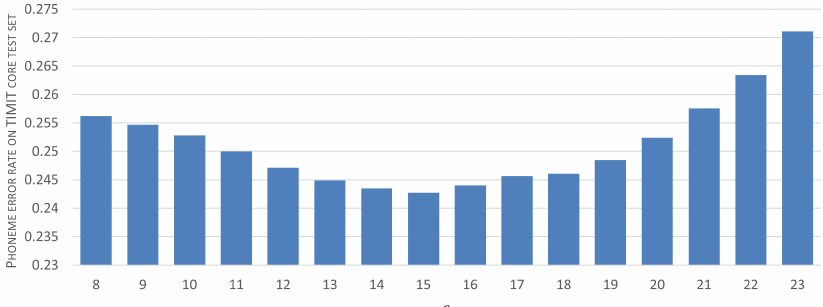
Figure 6. Distribution of Phoneme Error Rates for different phoneme-detection thresholds and a simple CNN classifier (central-window scheme, N FB = 128, WL = 256, n DFT =